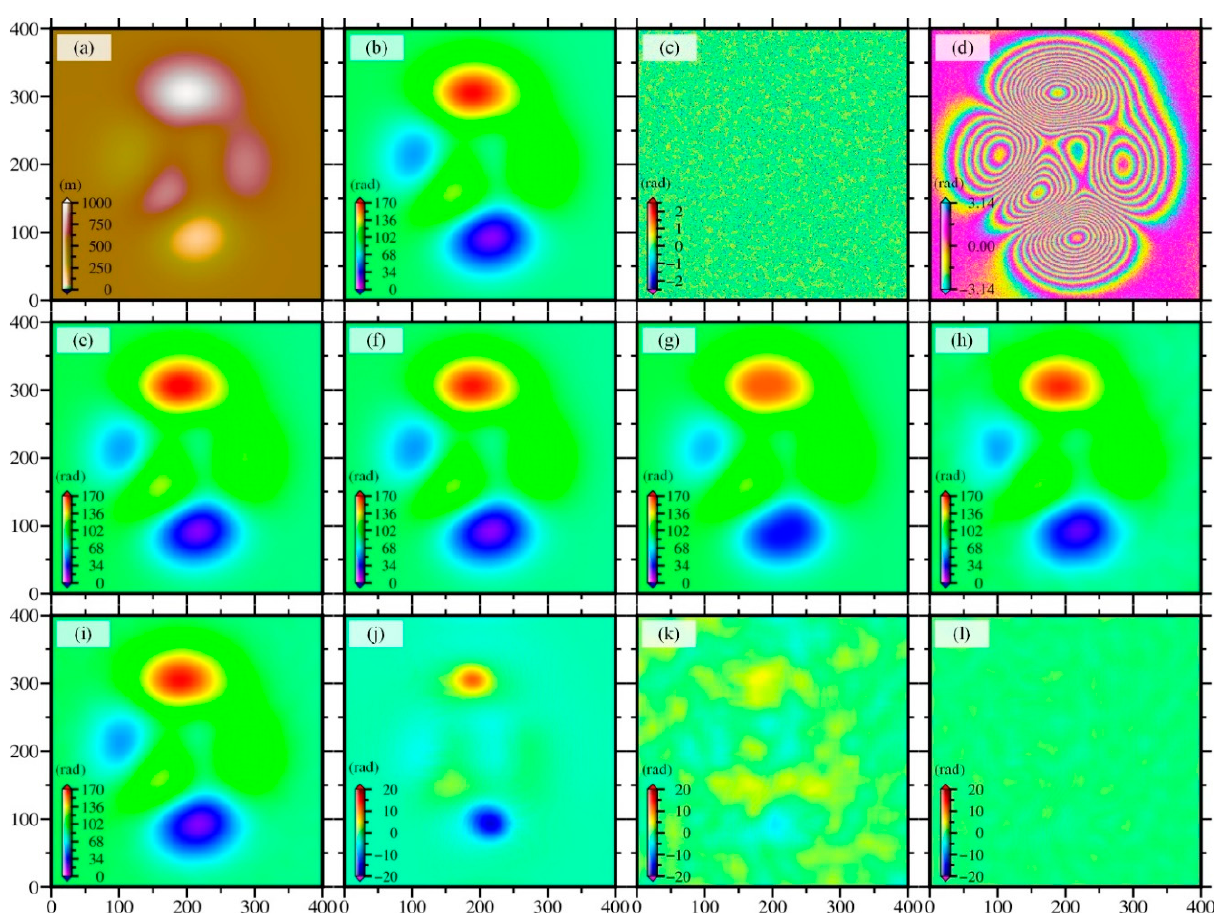
Figure 2. Performance comparison of the conventional InSAR, RSSI, and RID methods based on the simulated data set: ( a ) represents the simulated DEM; ( b ) is the unwrapped phase converted from ( a ), i.e., full-bandwidth InSAR-based DEM phase; ( c ) is the Gaussian noise, and ( d ) is the rewrapped phase of ( b ) added ( c ); ( e , f ) show the simulated noisy high- and low-frequency DEM interferometric phases; ( g – i ) represent the terrain phase from conventional InSAR, RSSI, and RID methods, respectively; ( j – l ) present the differences between ( b , g – i ). Table 1. Major Parameters of the Simulated InSAR